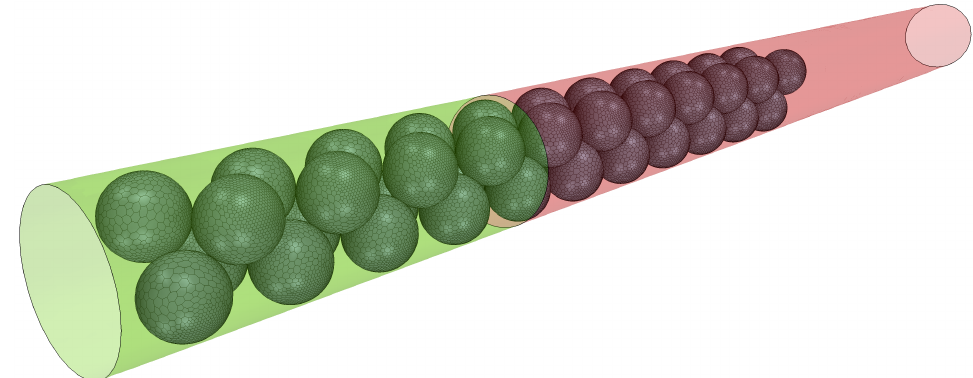
Figure 5. Sketch of the experimental and numerical setup of the pre-study. The heating zone starts behind the light green zone, flow direction is from left to right.